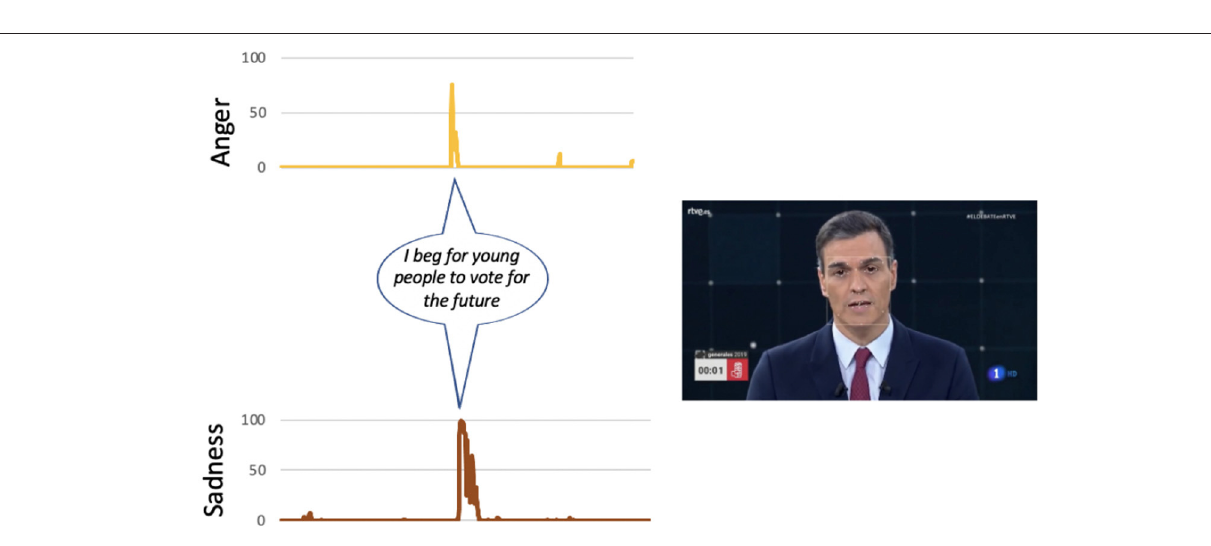
FIGURE 8 | The main phrases of Albert Rivera’s speech during the golden minute associated with certain